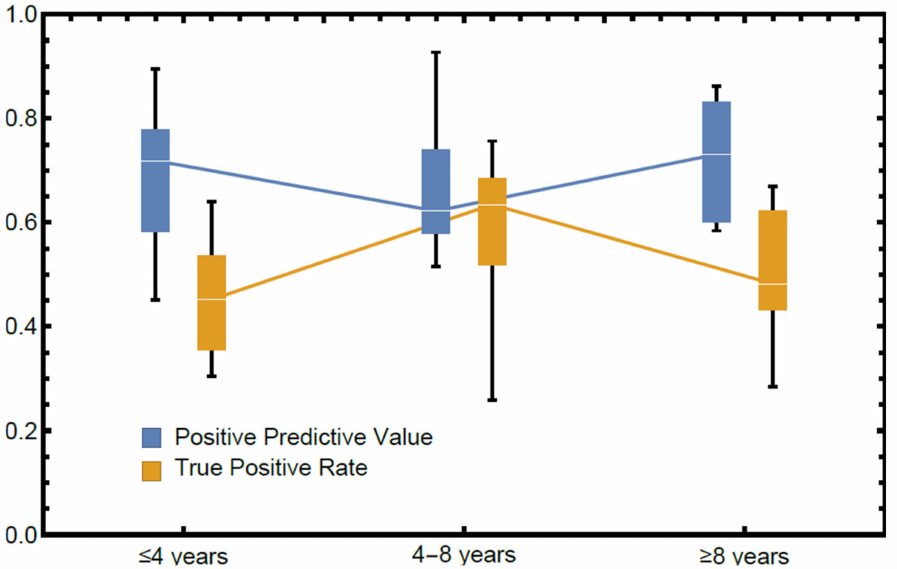
Figure 3. Performance stratified by self-reported years of experience in diagnosing panoramic radiographs (lines indicate median, boxes span the first and third quartiles and fences span the total range). Groups contain 9 ( ≤ 4 years), 6 (4–8 years), and 9 ( ≥ 8 years) OMF surgeons,